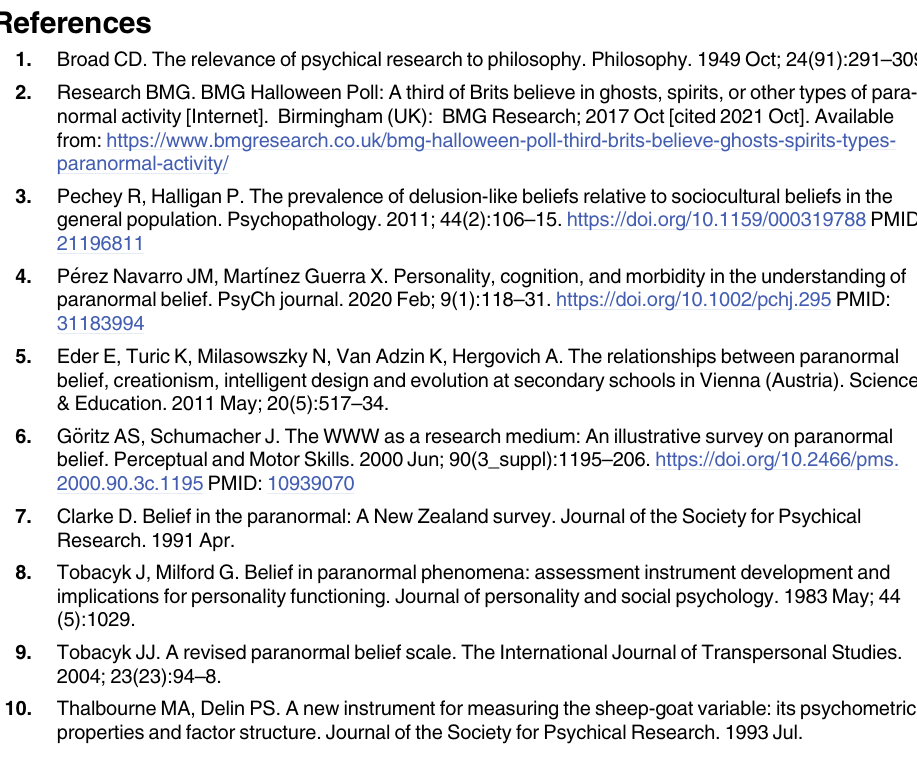
S9 Table. Alternate categorisations for studies included in the review. Note: ✓ = original category, ✓ = alternate